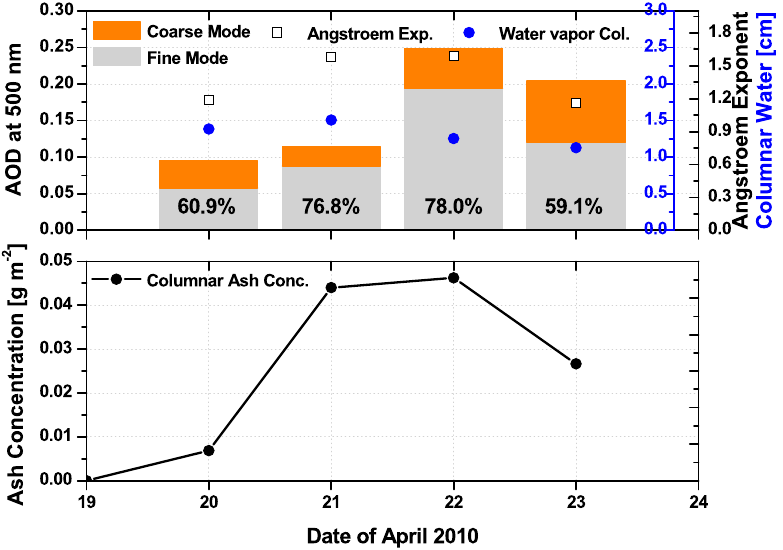
Fig. 7. AERONET fine/coarse-mode aerosol optical depth (AOD) obtained over Athens at 500nm for the period between 19 and 24 April 2010, and Ångström exponent of 440nm/870nm along with the columnar water vapor (in cm) (upper graph). Temporal evolution of the volcanic ash columnar concentration (in gm − 2 ) according to FLEXPART simulations (lower